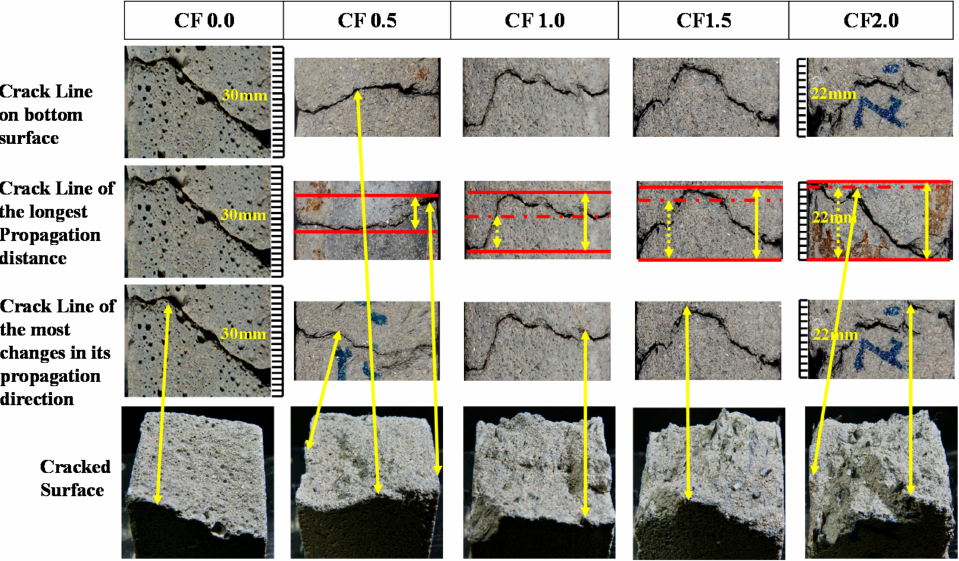
Figure 2. Crack lines and surface roughness of the cracked surfaces of prism sample of different fiber